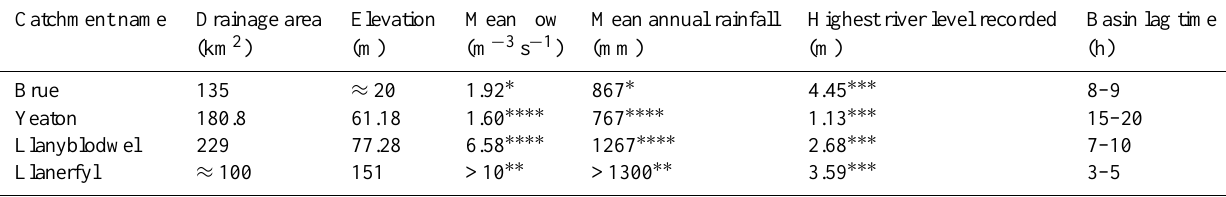
Table 1. Summary of the main basin characteristics for the catchments selected.